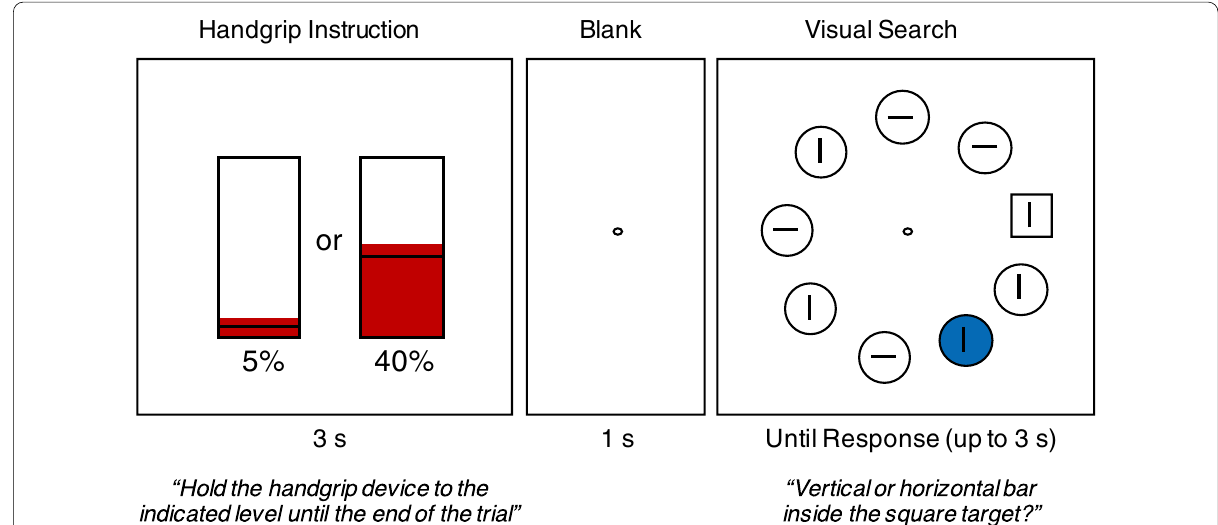
Fig. 1 Illustration of the stimuli and task procedure for the handgrip–search dual task. Each trial began with the handgrip initiation to the required %MVC for 3 s with immediate visual feedback of exerted grip force shown on the screen. Participants were instructed to hold the grip force throughout the visual search task. For the visual search task, a search array appeared following a 1‑s of center fixation and it stayed until the response (up to 3 s). The search array consisted of one target square and eight distractor circles evenly distributed on an imaginary circle. Each search item had a bar inside the outline shape. Participants were required to make a speeded response to report the orientation (vertical or horizontal) of the bar inside the target shape. On half of the trials, one of the circle distractors had a randomly chosen color background. This